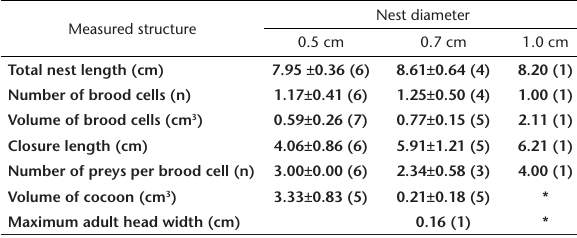
Table 1. Structure of nests of Liris sp. of different diameters and adult and cocoon measurements. Values are means ± standard deviation. Values between blankets are the number of nests or cells